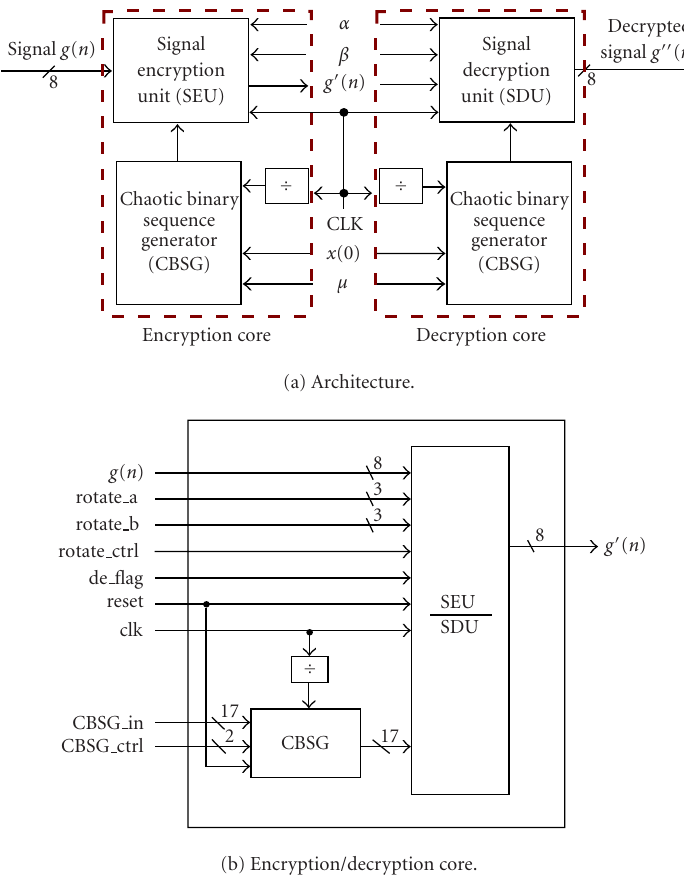
Figure 4: The architecture of the proposed signal security